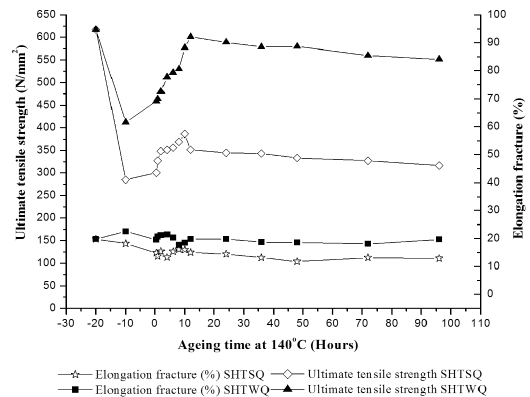
Figure 3. The relationship between ageing time and UTS and elongation fracture for SHTWQ and SHTSQ & 8% pre-strained test samples aged at 140